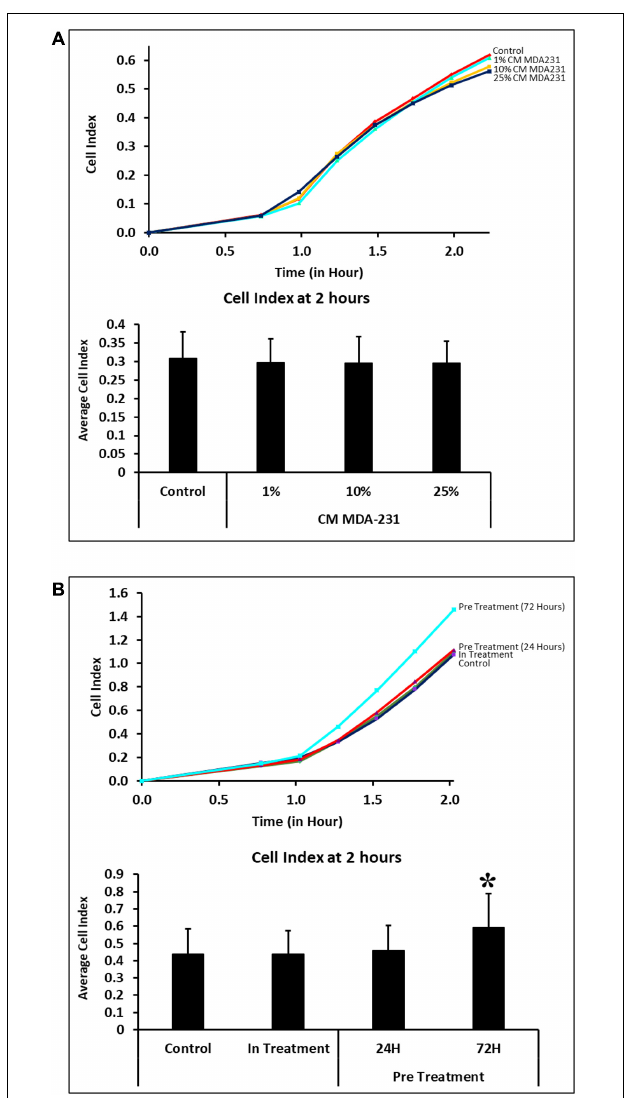
FIGURE 2 | Adhesion of CV-MSCs in response to CM-MDA231 (in-treatment) and after preconditioning. Cellular adhesion data as observed with the xCELLigence system indicate that in response to 1–25% CMMDA-231 (under in-treatment conditions), CV-MSCs adhesion did not change significantly ( P > 0.05) at 2 h as compared to untreated control (A) . However, prior preconditioning for 72 and subsequent adhesion analysis showed a significant increase in adhesion as compared to 24 h precondition, in-treatment and untreated control (B) . Each experiment was repeated three times with cells isolated from five independent placentae. Bars represent standard errors * P <